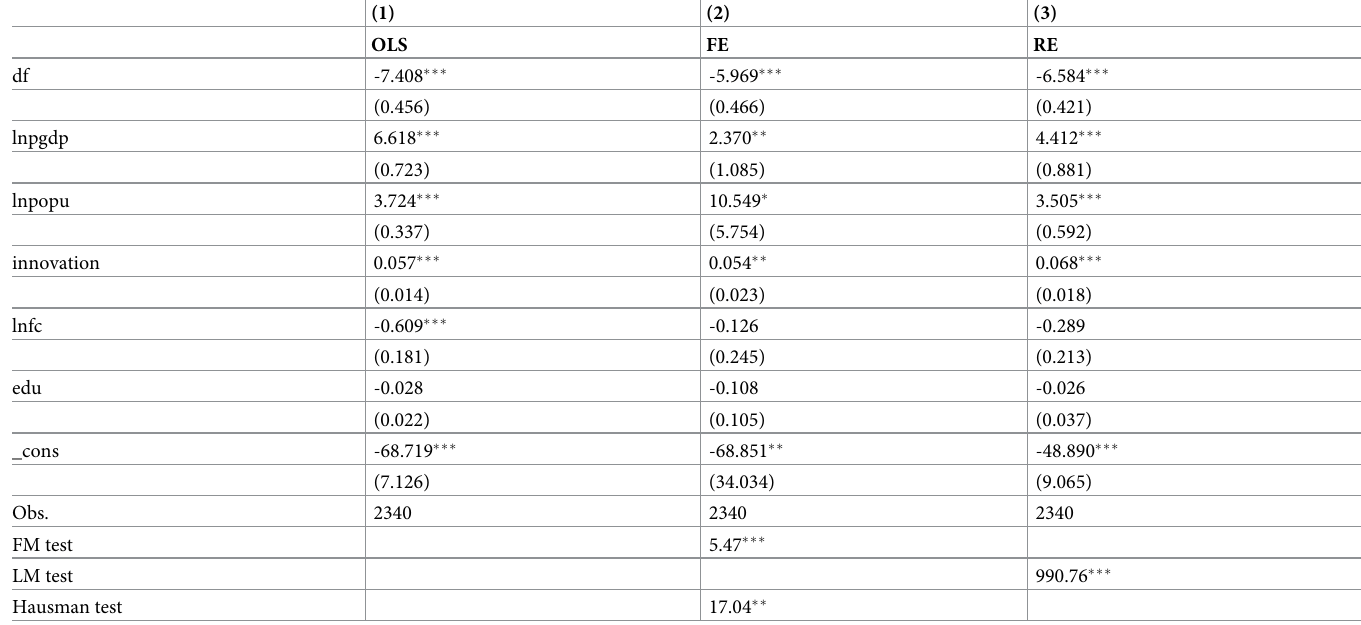
Table 3. Basic regression